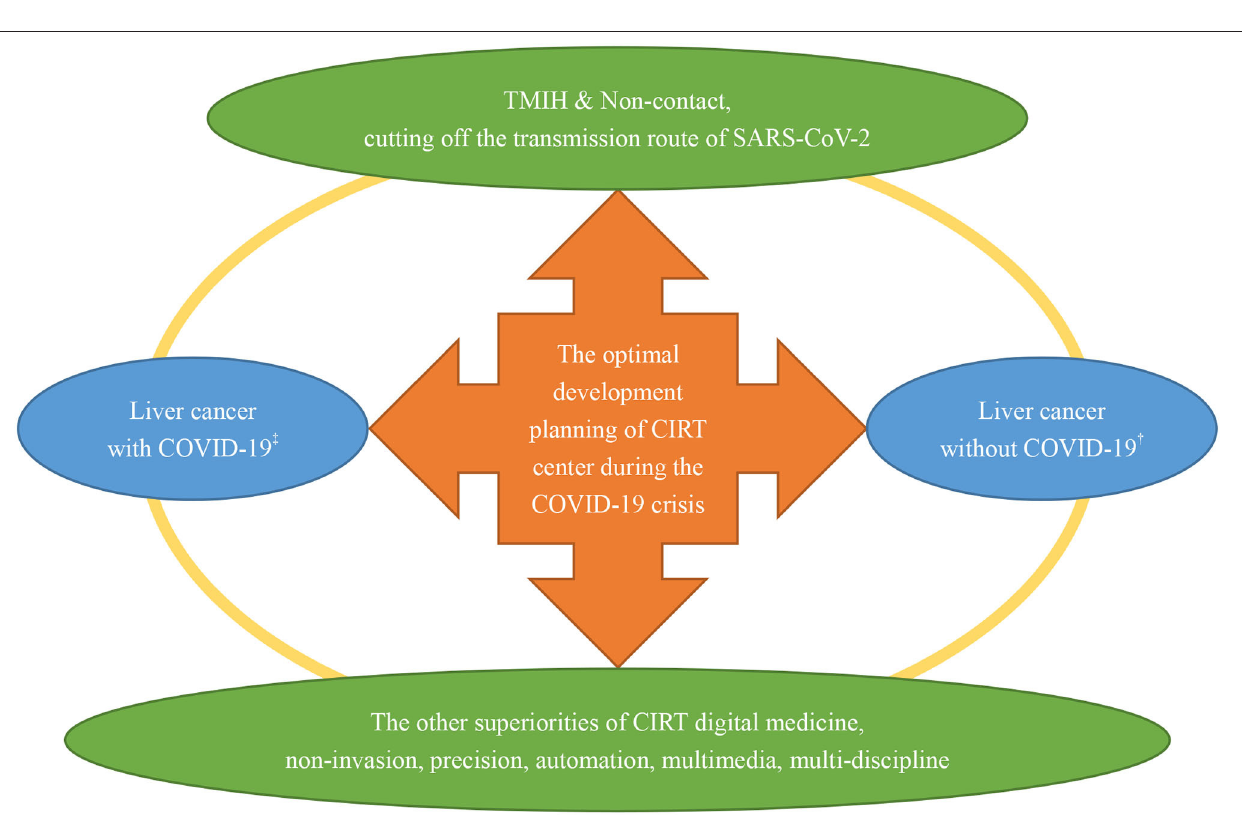
FIGURE 2 | A schematic diagram for the development planning of the CIRT center during the COVID-19 crisis. CIRT, carbon ion radiotherapy; ‡ liver cancer patients with concurrent SARS-CoV-2 infection; † liver cancer patients without SARS-CoV-2